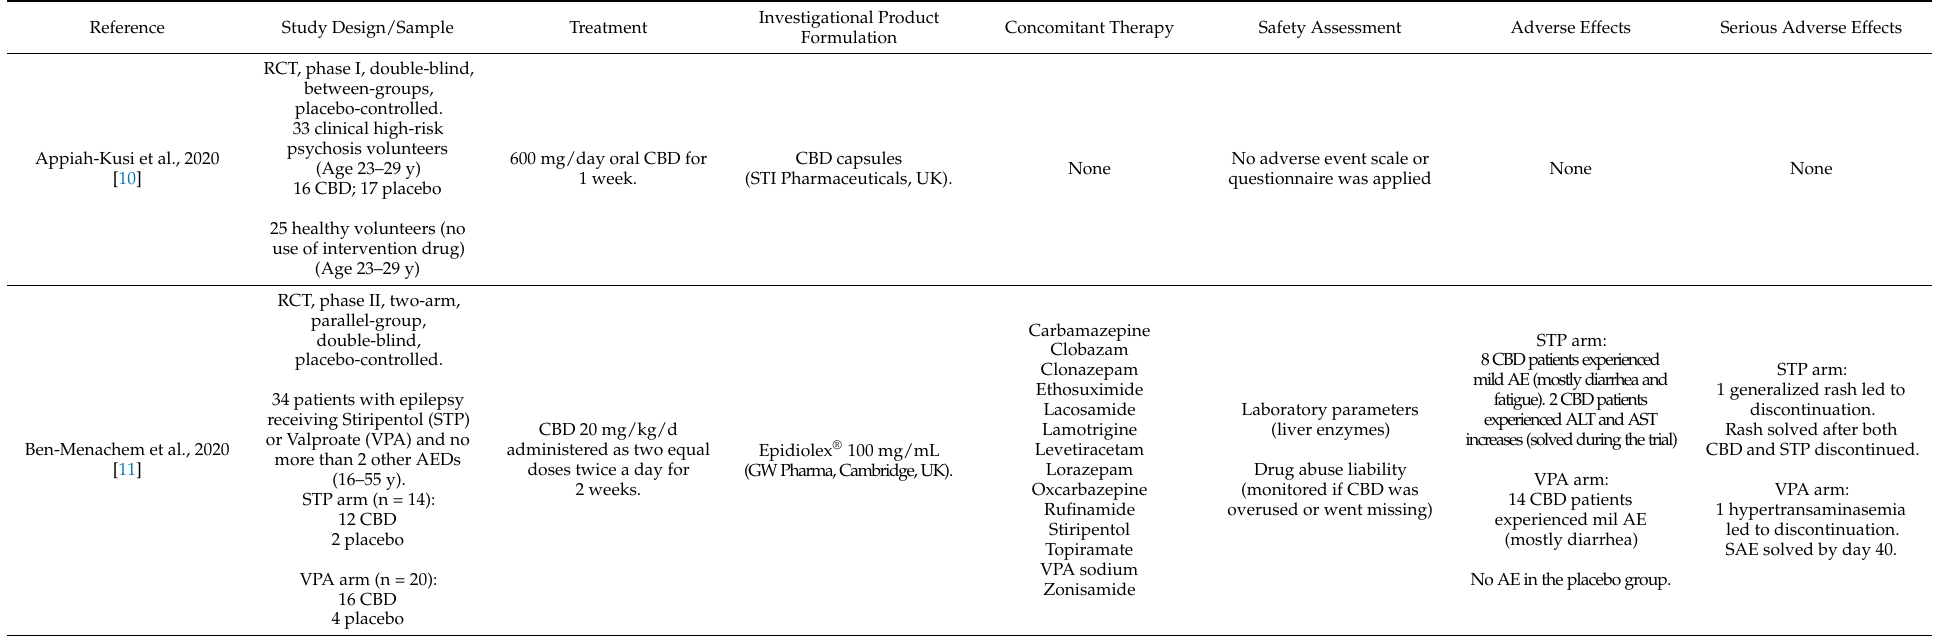
Table 1. A visual summary of the characteristics from included studies from the systematic